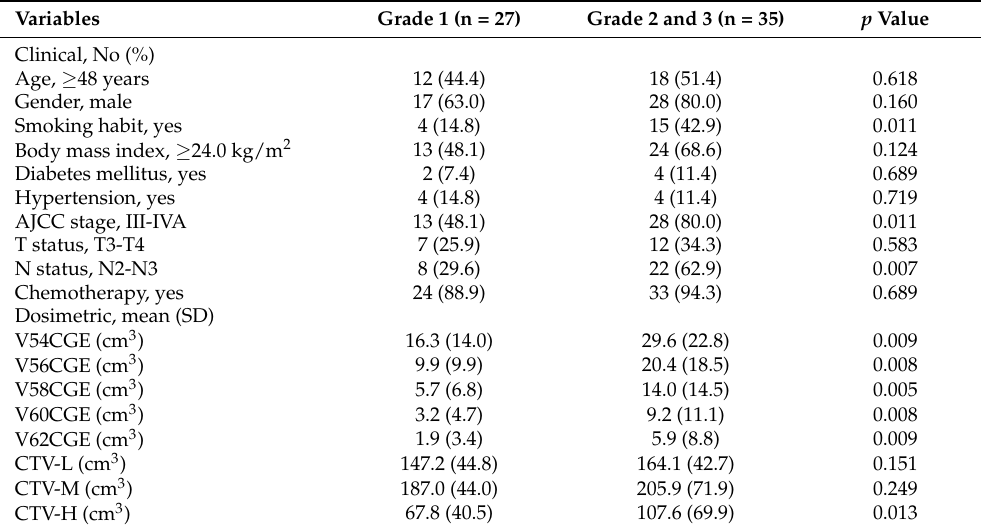
Table 2. Univariateanalysisofclinicalanddosimetricpredictorsofgrade2and3acuteradiationdermatitis. Variables